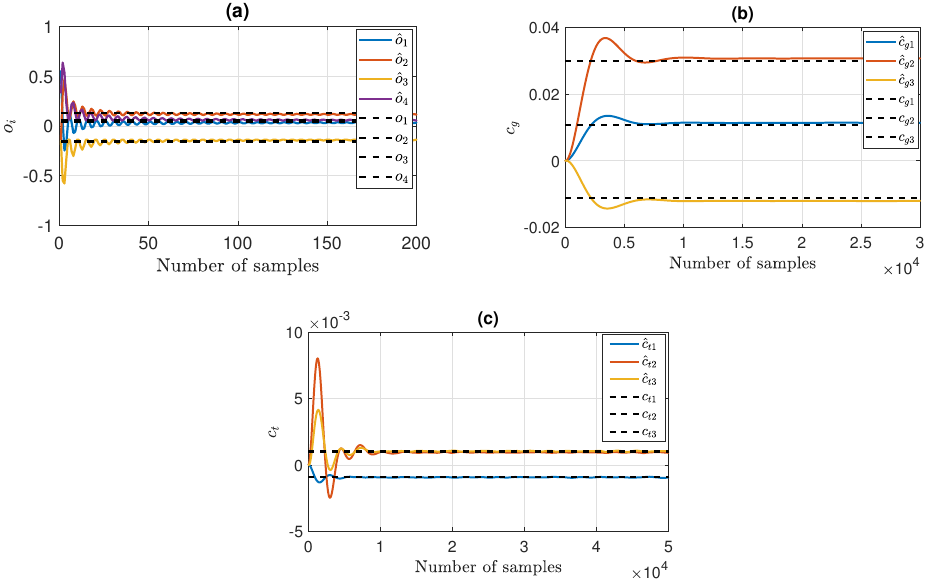
Figure 10. The output spectrum after and before calibration on the FPGA hardware implementation of the proposed technique.